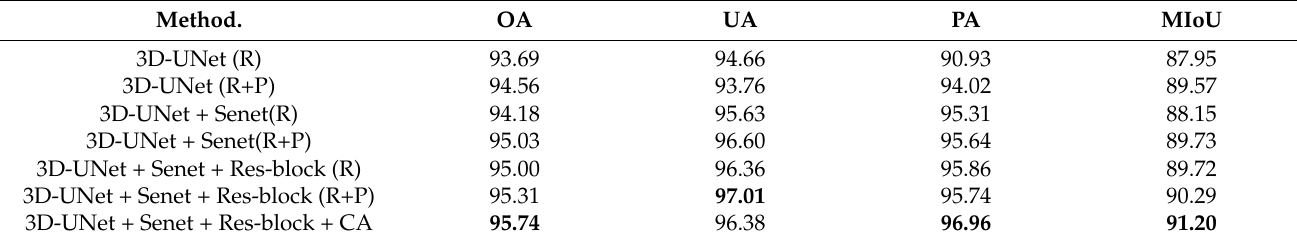
Table 4. The cloud detection accuracy (%) for ablation